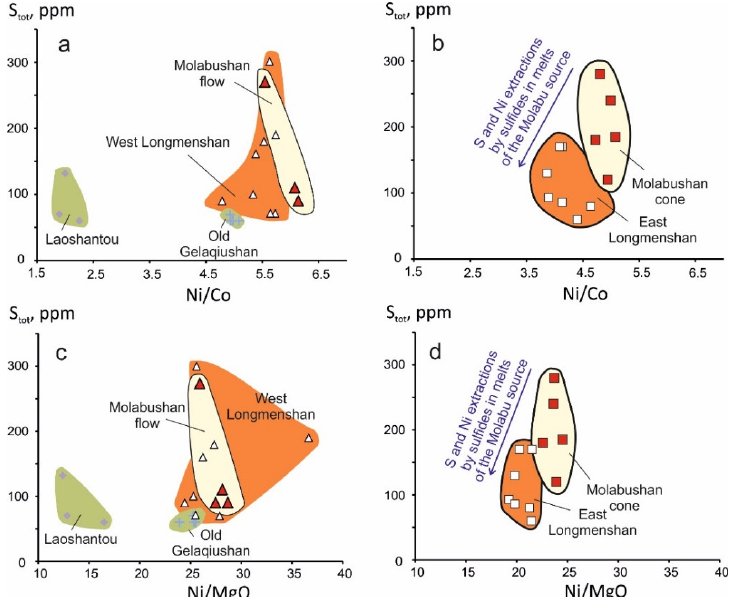
Figure 13. S versus Ni/Co ( a , c ) and Ni/MgO ( b , d ) diagrams. Symbols are as in Figure 5.